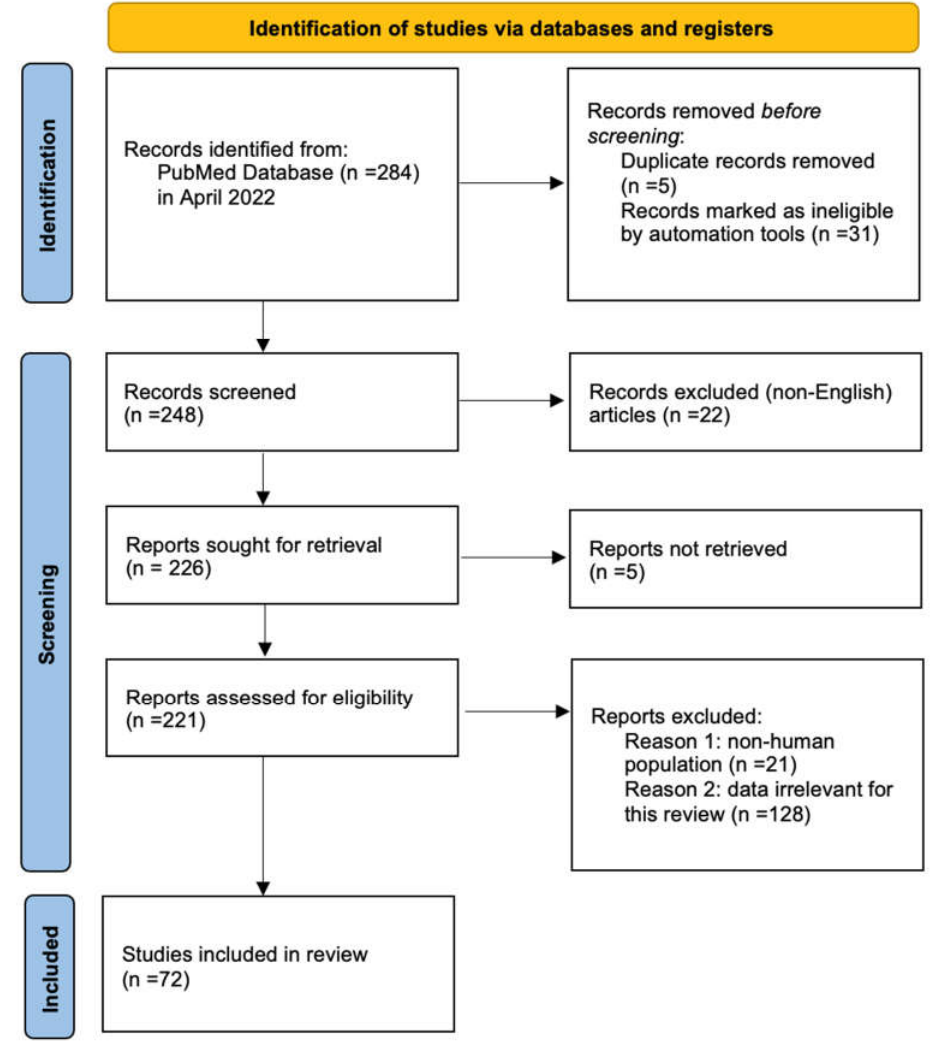
Figure 1. PRISMA flow diagram 2020. Adapted from Page et al. [32].